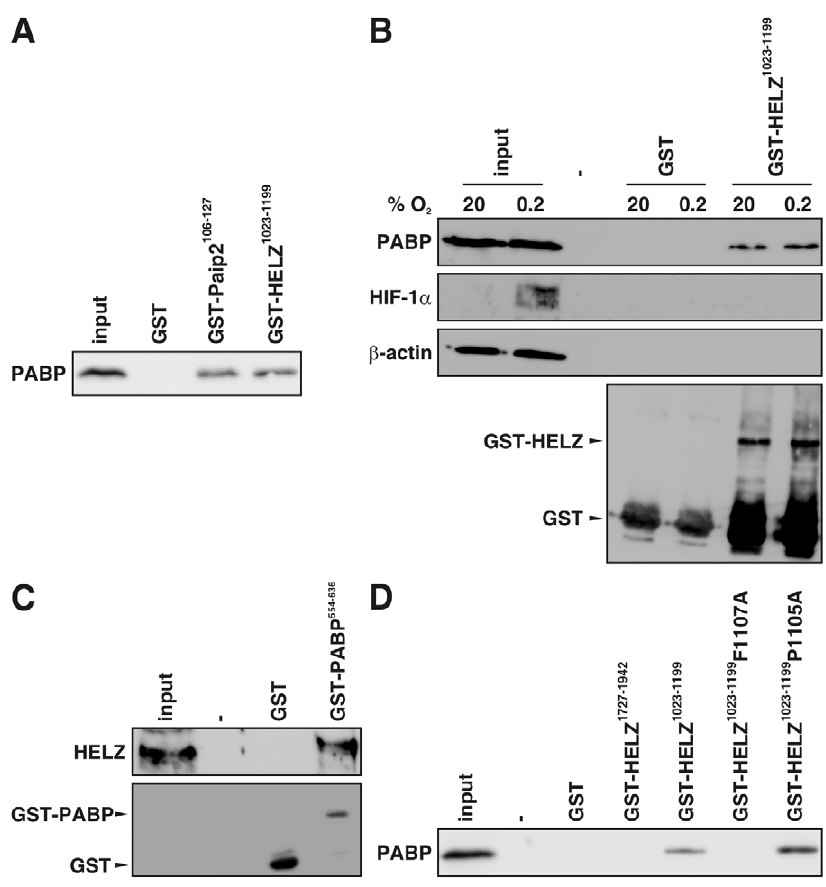
Figure 3. HELZ interacts with the poly(A)-binding protein (PABP). GST pull-down using glutathione-sepharose beads was conducted by incubating crude HeLa cell lysates with recombinant GST, GST-Paip2 106–127 and GST-HELZ 1023–1199 ( A ), GST and the indicated GST-HELZ fragments ( D ), or crude HEK293 cell lysates with GST and GST-PABP 554–636 ( C ). Hypoxic HeLa cell lysates were incubated with GST or GST-HELZ 1023–1199 ( B ). Eluates were subjected to SDS-PAGE and immunoblotting using the indicated antibodies.